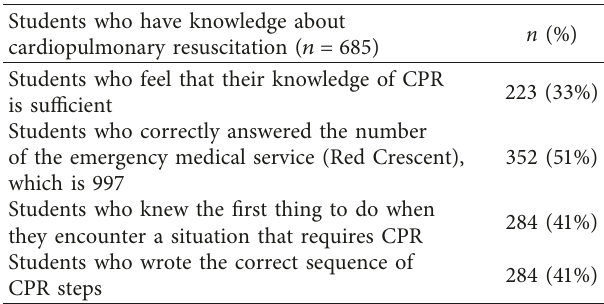
Table 3: Estimating the knowledge about